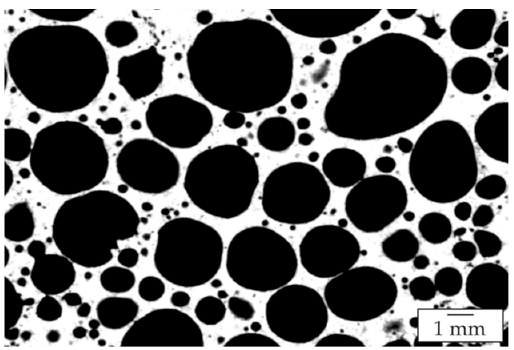
Figure 13. Section of the XRM image of sample no. 21 with foaming temperature of 650 °C, foaming duration of 5 min, 0.2 wt.% TiH 2 with wall rupture events marked in red.